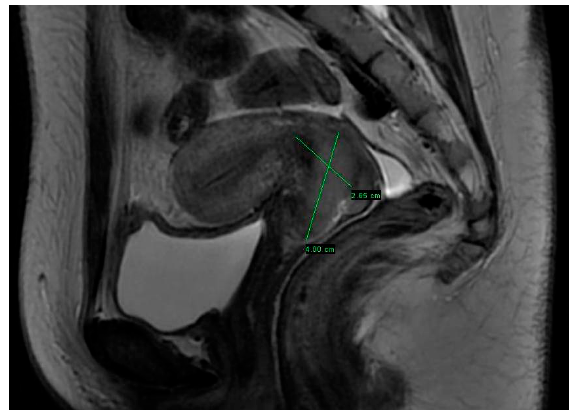
Figure 1. Pelvic MRI performed at the initial evaluation of the patient, revealing cervical tumor 40 mm in the longest diameter. 40 mm in the longest